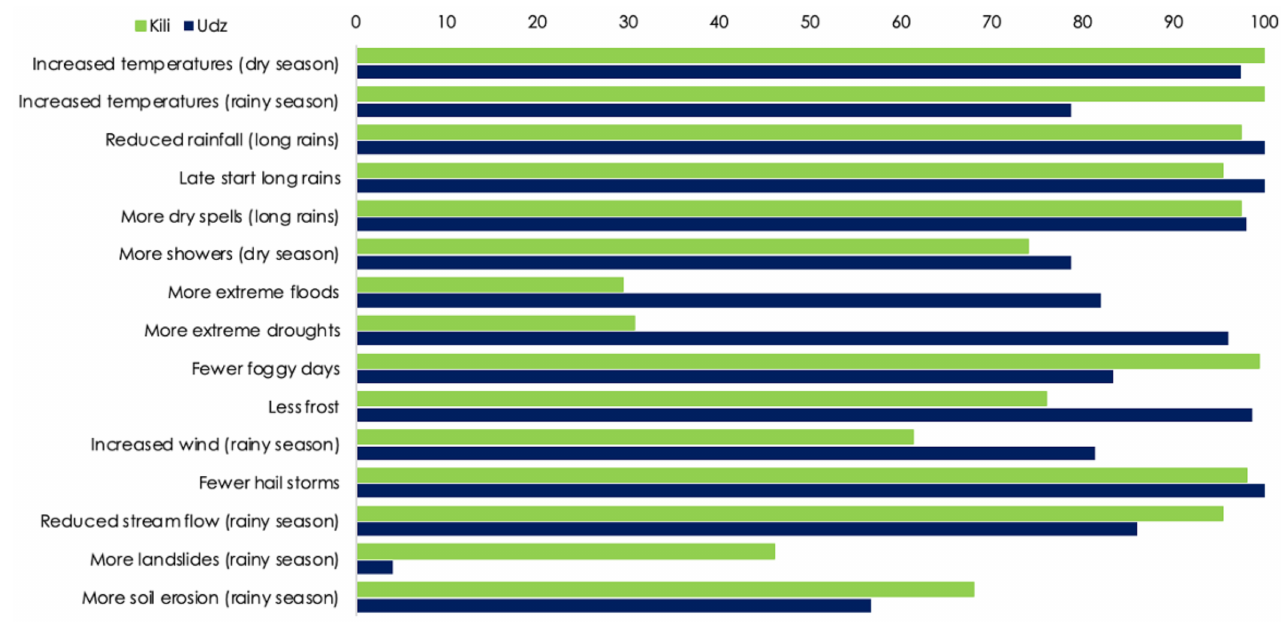
Figure 2. Observed changes in climate and impacts in the physical domain in terms of percentage of respondents in each mountain ( n = 150 on Mount Kilimanjaro, n = 150 on the Udzungwa Mountains). On the Udzungwa Mountains, long rains refer to the only rainy season found on the north-western slopes. We did not specifically ask every respondent on Mount Kilimanjaro about the short rains, so these are not included in Figure